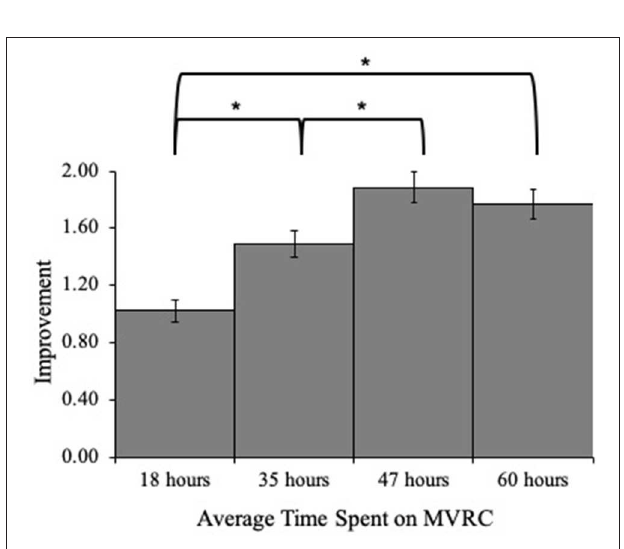
FIGURE 4 | Average improvement of 5th-grade reading fluency, as a function of hours practiced (separated into quartiles). Error bars represent standard errors. *Significant difference obtained with Bonferroni pair-wise comparisons ( p < 0.05).